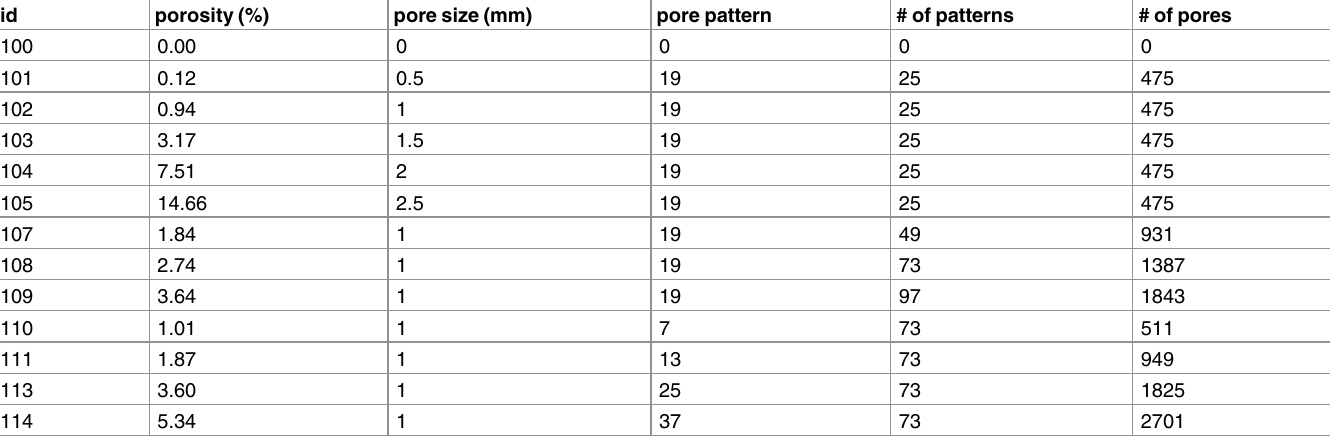
Table 1. Design parameters of the manufactured